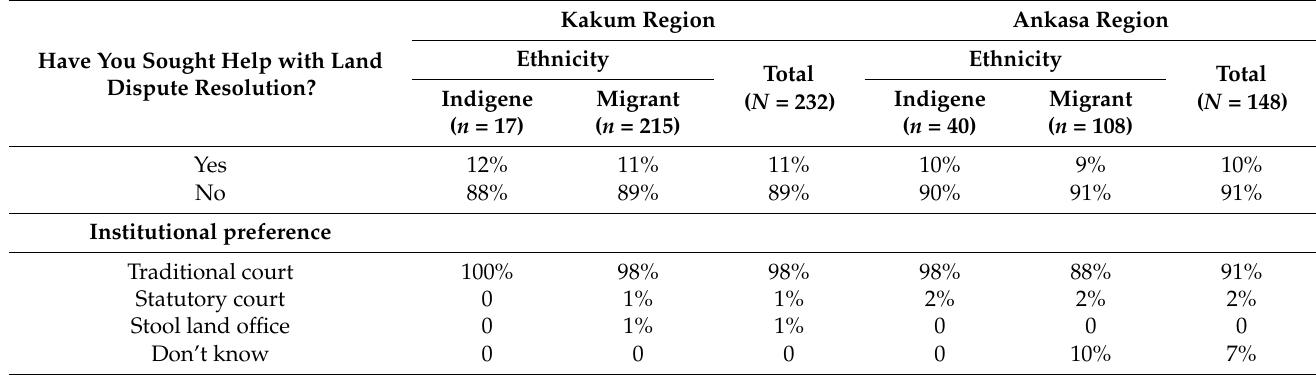
Table 3. Mechanisms for land dispute